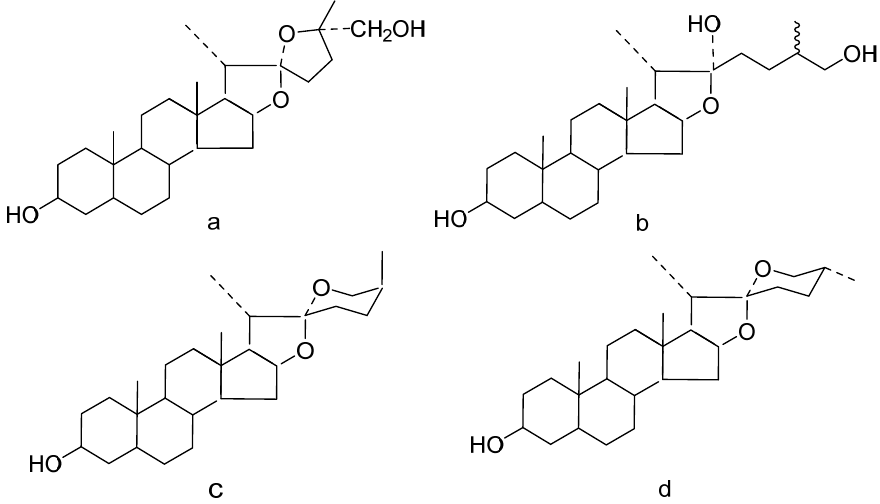
Figure 3. Chemical structures of four kinds of steroidal saponins, ( a ) deformed spirostanol types, ( b ) furostanol, ( c ) spirostanol, ( d ) isospirostanol. Table 1. Efficacy table of Chinese medicinal materials mainly containing saponins. No.